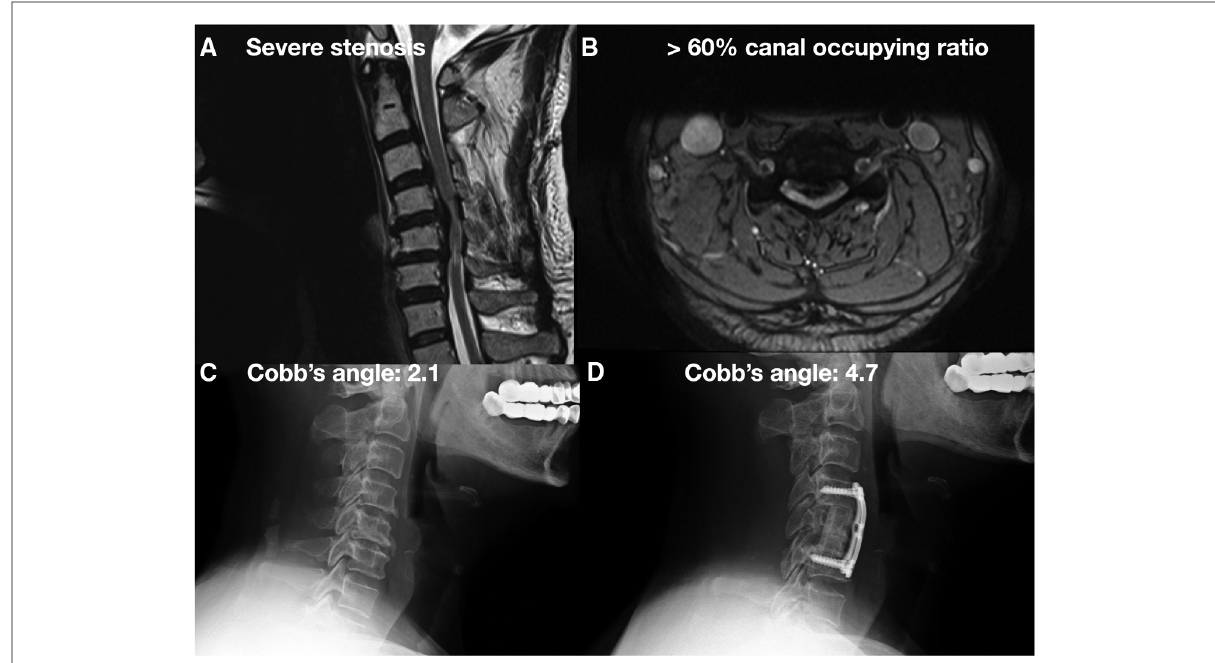
FIGURE 1 A 63-year-old male with CM due to long-segment massive OPLL over C3-6 underwent C3-6 laminectomy followed by anterior C4-5 and C5-6 microdiscectomy and C5 corpectomy, and C4-6 interbody fusion and internal fi xation. ( A ) Preoperative cervical MRI showed severe cervical stenosis with bulging disc. ( B ) Preoperative cervical MRI axial view showed >60% canal occupying ratio. ( C ) Preoperative cervical x-ray showed cervical lordosis about 2.1°. ( D ) Postoperative cervical x-ray showed cervical lordosis about